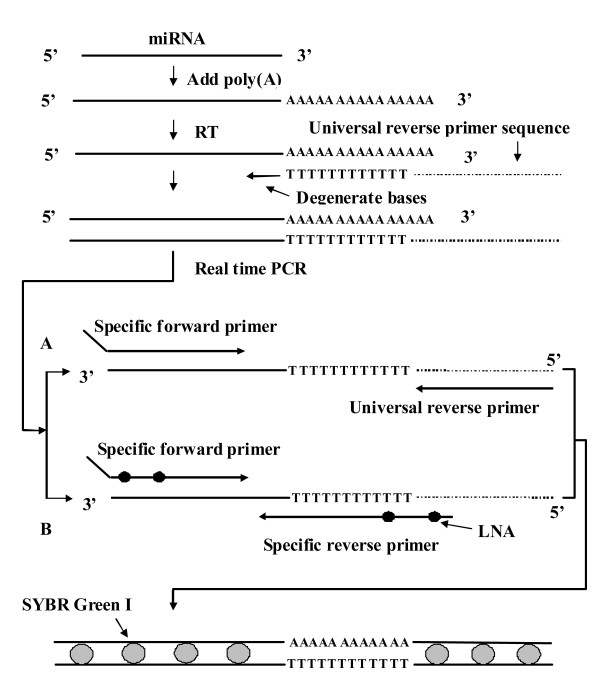
Schematic representation of the poly(A) method used to study miRNA expression. After polyadenylation, the reverse transcription of miRNA is carried out using a universal RT primer that contains degenerate nucleotides at 3' end followed by an oligo(dT) and universal reverse primer sequence. The cDNA is amplified with either (A) specific forward and universal reverse primers or (B) LNA-integrated specific forward and specific reverse primers. The amplification products are detected by SYBR Green I.